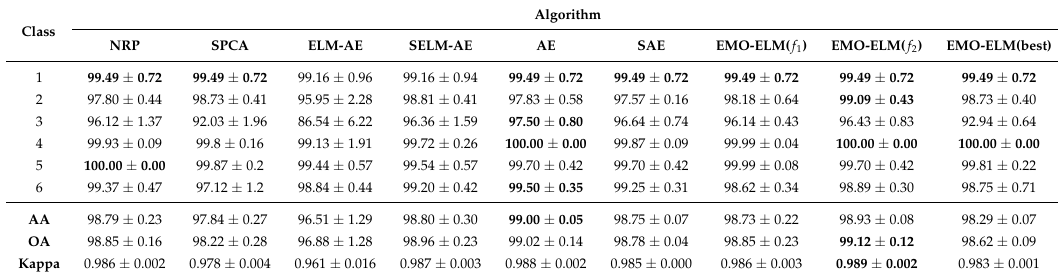
Table 3. The performance comparison of SalinasA for NRP, SPCA, ELM-AE, SELM-AE, AE, SAE and